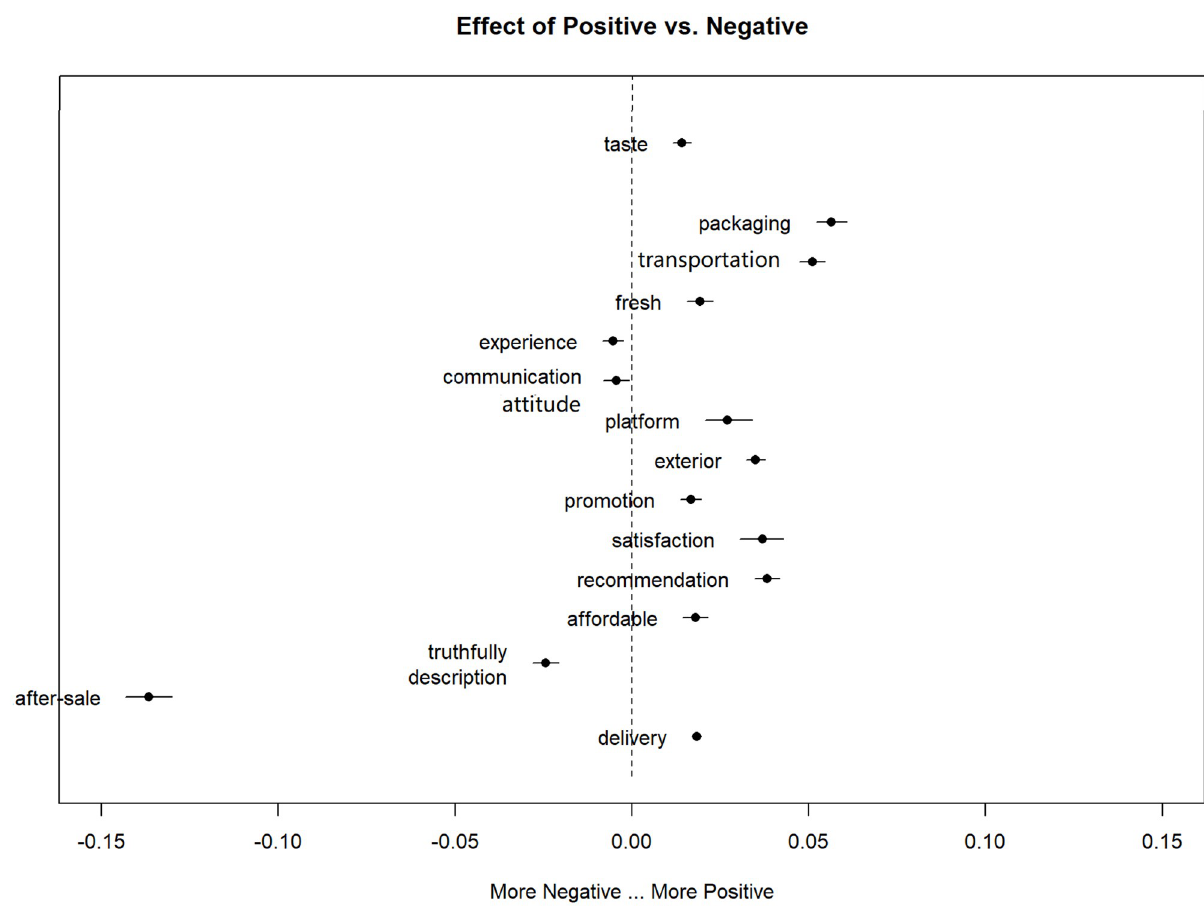
Fig 3. Comparison between different reviews